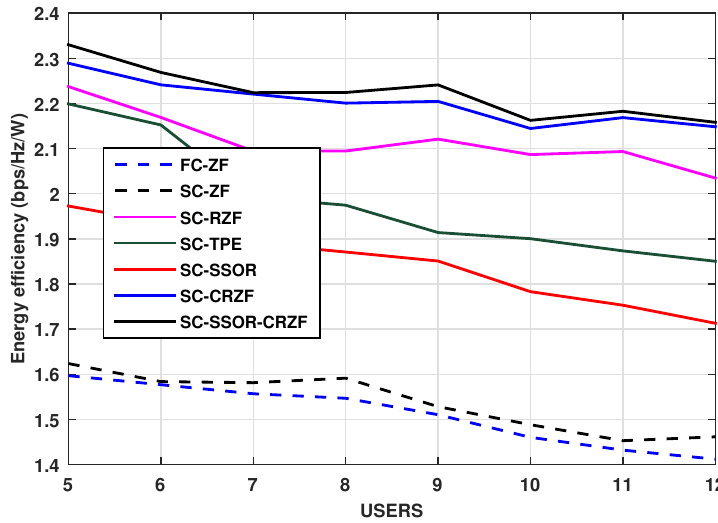
Figure 6. Energy Efficiency Variation with the No. of